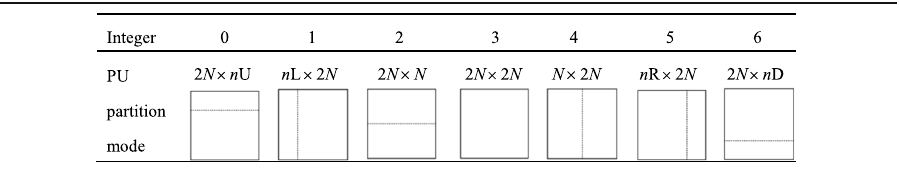
Table 7 Mapping 1 of PU partition modes for 16× 16-sized CU